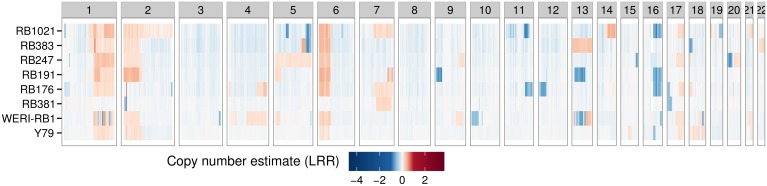
Copy numbers in retinoblastoma cell lines.Genome-wide heat map of SCNAs in 8 retinoblastoma cell lines. Sex chromosomes are not displayed since no matching reference was available. SCNA-amplitudes are expressed as Log2-ratio and mapped to a blue-to-red continuous color-scale.